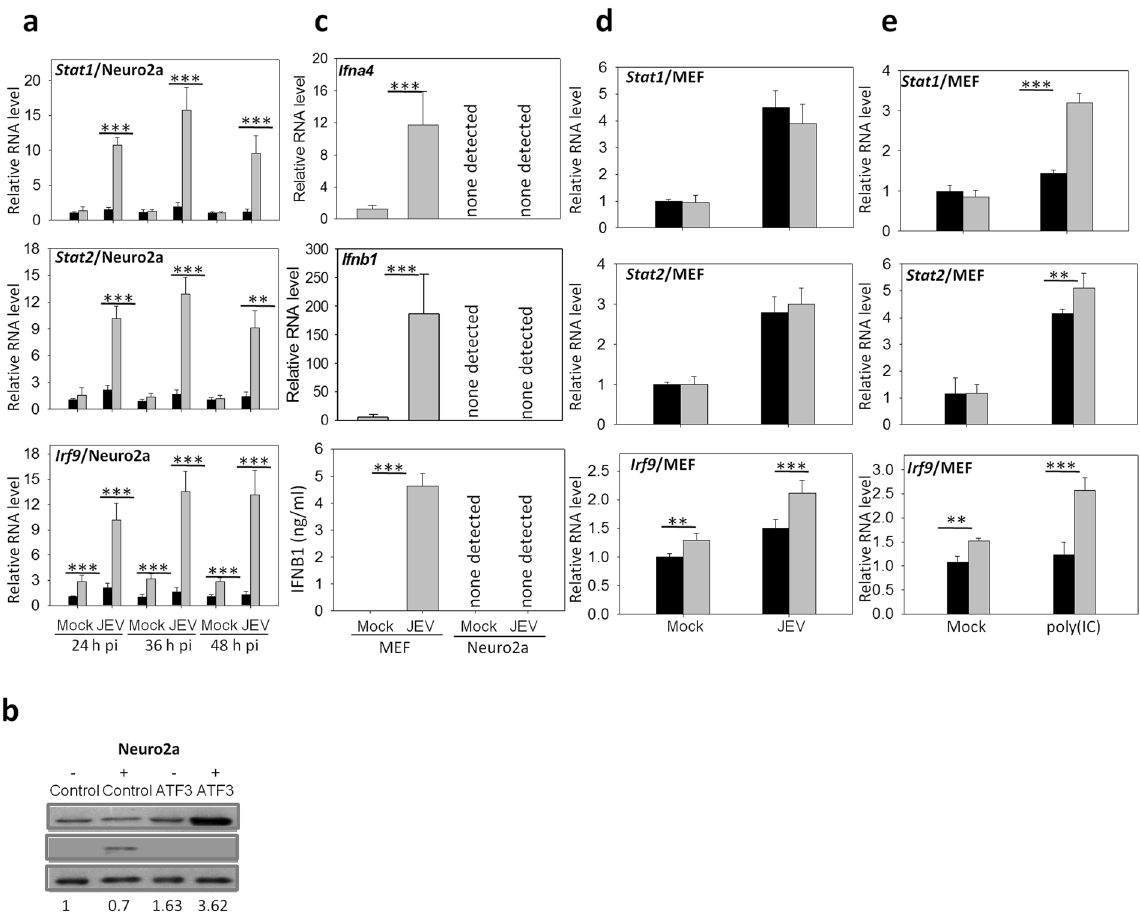
Figure 3. ATF3 negatively regulates tyvpe I interferon system. ( a ) Neuro2a cells were treated with either a control non-targeting or the Atf3 -specific siRNA for 48 h and then infected with JEV (MOI 5) for different time points. qRT PCR was done to quantify the relative levels of STAT and IRF family gene transcripts in control siRNA-treated cells (black bars) or the Atf3 siRNA-treated cells (grey bars). ( b ) Lysates from siRNA-treated JEV-infected ( + ) and mock-infected ( − ) cells were western blotted. Cells treated with control siRNA when infected with JEV showed a high level of ATF3 expression seen as a prominent band. Shown below is the ratio of STAT1/GAPDH. On a longer exposure of the blot the two isoforms of STAT1 could be seen (not shown here). ( c ) Neuro2a or MEF cells were mock-infected or infected with JEV (MOI 5). At 24 h pi qRT PCR was done to quantify the relative levels of Ifna4 and Ifnb1 transcripts in the cells. These transcripts were not detected in Neuro2a cells whereas they were upregulated in MEF cells following the infection. The lowest panel shows the levels of IFNb1 in the culture soup. IFNb1 could not be detected in Neuro2a cells whereas its levels were upregulated in MEF cells following JEV infection. ( d ) MEF cells were treated with control siRNA (black bars) or Atf3- specific siRNA (grey bars) and then infected with JEV. At 24 h pi qRT PCR was done to quantify the relative levels of Stat1, Stat2 and Irf9 transcripts. ( e ) MEF cells were treated with control siRNA (black bars) or Atf3- specific siRNA (grey bars) and then transfected with 1 μ g/ml poly(IC). At 24 h post-transfection, qRT PCR was done to quantify the relative levels of Stat1, Stat2 and Irf9 transcripts. All the experiments were done in triplicates on three different occasions. The Gapdh levels were used for normalization. The statistical significance of the difference between the data was established by Student’s t-test; * p < 0.05; ** p < 0.01; *** p <